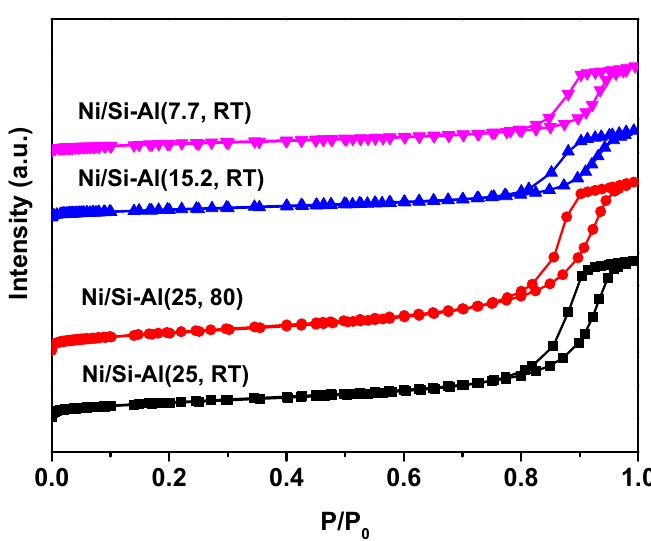
Figure 3. N 2 adsorption ‐ desorption isotherms at 77 K determined on Ni/Si ‐ Al(x,y).